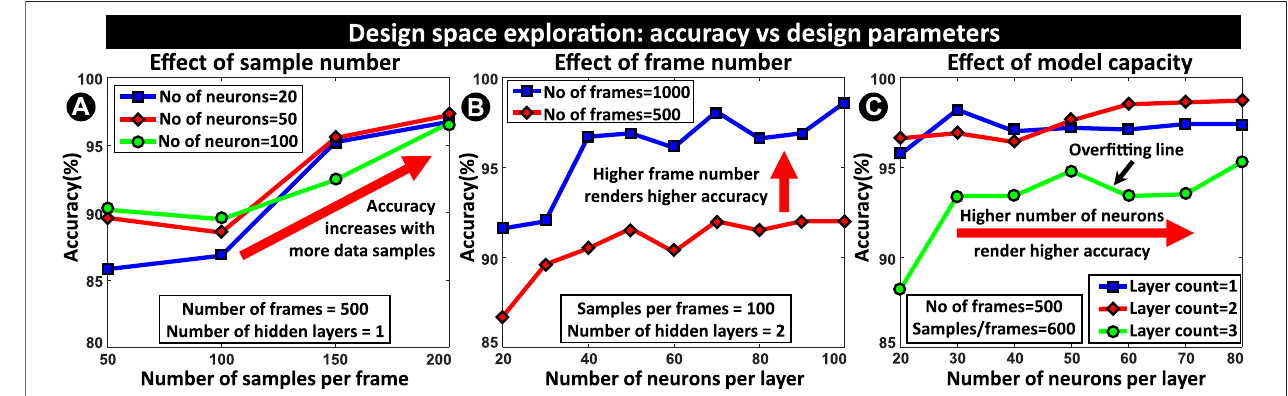
FIGURE5 | (A) Detection accuracy vs. the number ofsamplesper frame for different neural networks which shows atrend of accuracy improvement(indicated by red arrow) with the increase in sample number. (B) Detection accuracy for different frame numbers shows higher frame number renders better performance. (C) Detection accuracy versus the number of neurons per layer. The general trend shows that accuracy improves with the increase in the number of neurons in each layer. Also, accuracy typically improves with more hidden layers until the higher model order causes over fi tting and degrades performance.